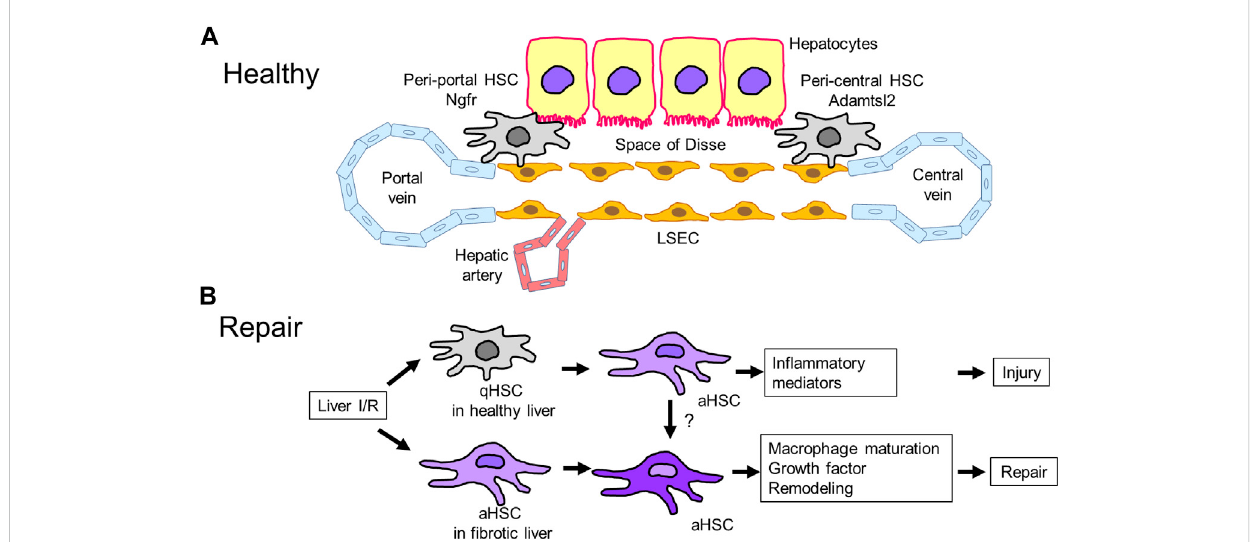
FIGURE 3 Hepatic stellate cells (HSCs) in liver repair (A) . HSCs reside in the space of Disse, which is a perisinusoidal space between LSECs and hepatocytes. HSCs in healthy livers include two subpopulations: peri-portal and peri-central HSCs. Peri-portal HSCs express nerve growth factor receptor (Ngfr), and peri-centralHSCs expressAdamts like2(Adamtsl2). (B) .LiverIRI inducesHSC transition fromquiescenttoactivated HSCs,leadingto thedevelopment of liverinjurythroughthereleaseofin fl ammatorymediators.Meanwhile,liverswithIRI-induced fi brosiscontainingactivatedHSCsminimizeinjuryand stimulate repair associated with macrophage polarization, remodeling by proteinase production, and release of growth factors, but the underlying mechanisms are currently unidenti fi ed. aHSC, activated HSC; qHSC, quiescent